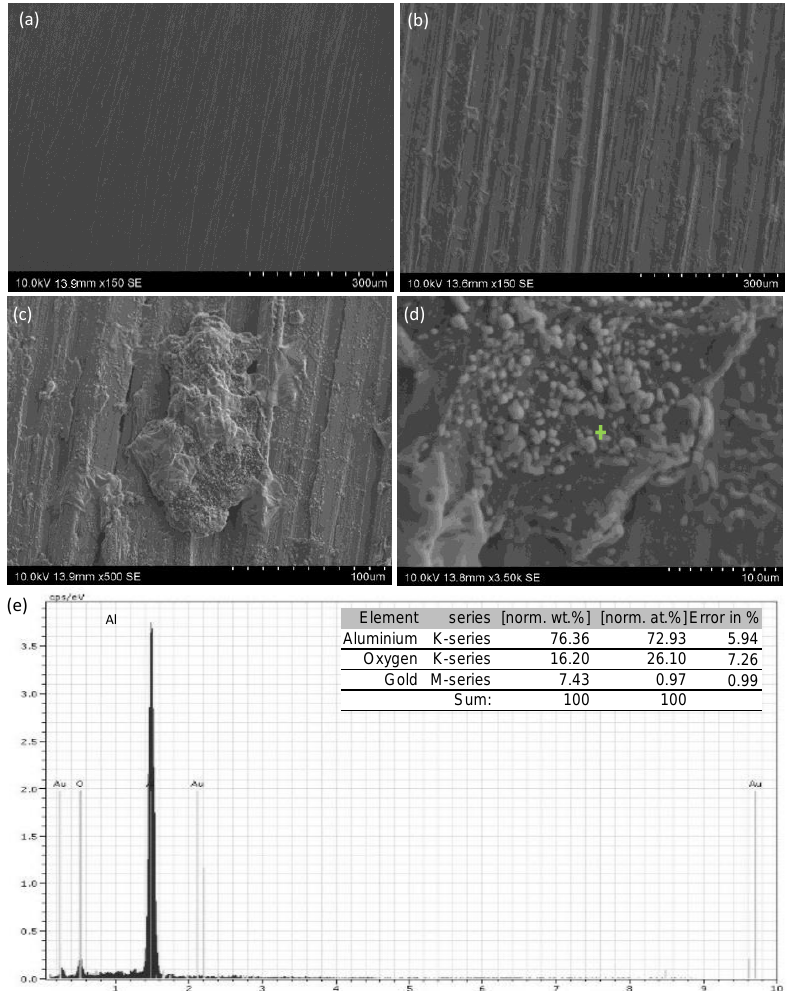
Figure 4. SEM images of the uncoated AA6082 alloy: ( a ) general view of surface before the immersion test in 3.5 wt.% NaCl; ( b ) general view after 168 h of immersion in 3.5 wt.% NaCl; ( c ) morphology of a corrosion product; ( d ) detail of ( c ); and ( e ) EDS analysis of zone marked in ( d ).